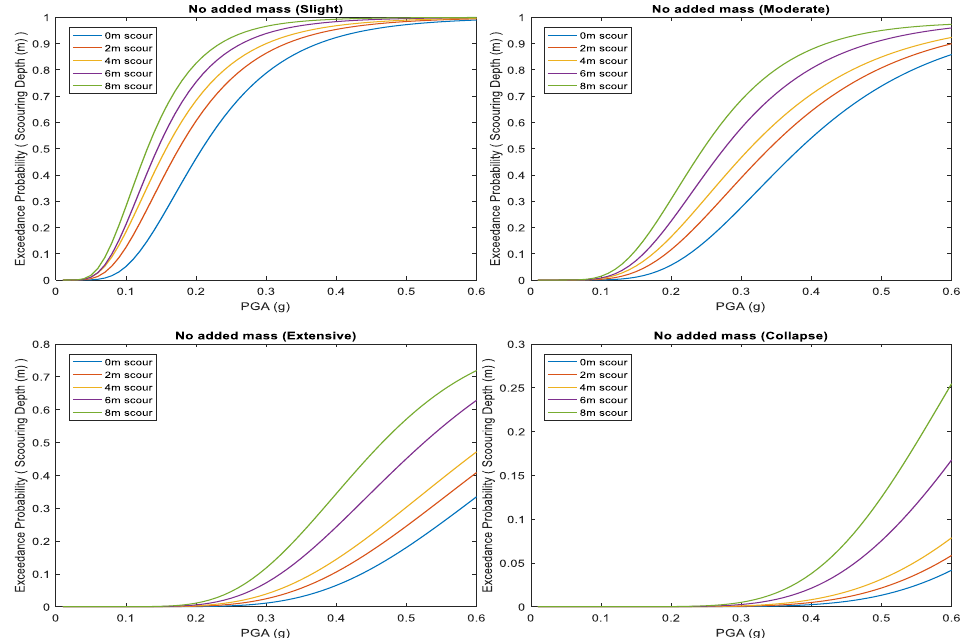
Figure 16. Fragility curves of each scouring depth under 0 m bridge water level and the same performance level.